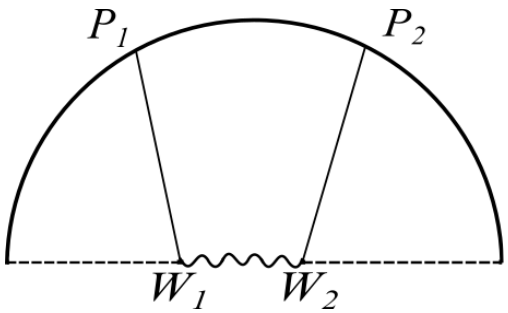
Figure 3 . The boundary exchange Witten